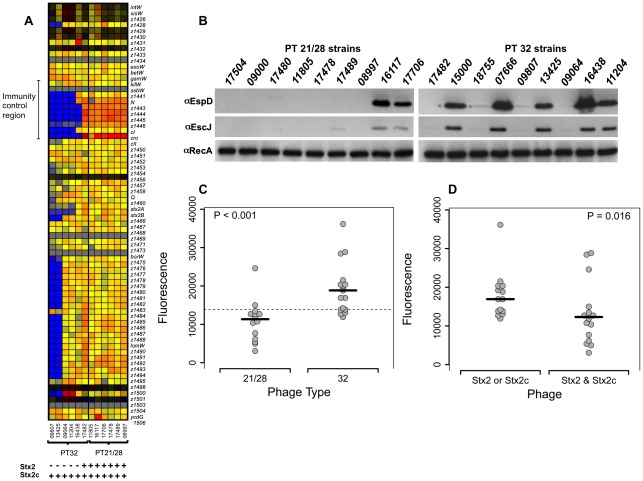
Comparison of EHEC O157 PT 21/28 and PT32 strains.(A) Comparative genome hybridisation of six PT21/28 and six PT32 strains. From left to right the PT21/28 strains are: 09807, 13425, 09064, 11204, 16438 & 17482; the PT32 strains are: 11805, 16117, 177706, 17478, 17489 & 08997 (table S1). The heat map shown indicates relative hybridisation levels of the defined strains to the Stx2 phage genome and flanking gene sequences from the O157:H7 Sakai strain which does not contain a Stx2c prophage. Red through to orange indicates a positive hybridization signal, with yellow a weakening signal through to blue colouration indicative of poor hybridization. All the PT21/28 strains show good relative hybridization to the sequences especially the gam-cII immunity region that is indicated. This is not the case for the PT32 strains with only 1 showing positive hybridisation over this same region, indicating that the remaining 5 strains are unlikely to contain the Stx2 phage. This was confirmed for the strains using a PCR to detect Stx2 and Stx2c phage control regions (Materials and Methods), the results of which are shown under the heat map lanes. The Stx phage distribution was then determined by PCR for 60 strains (table S1), please see Results section. (B) Western blot analysis of a subset of PT21/28 and PT32 strains as defined (table S1). EspD was detected from bacterial supernatants and EscJ and RecA from whole cell samples prepared as described in Materials and Methods. (C) Relative fluorescence levels from a LEE1-GFP reporter construct transformed into 14 PT21/28 and 16 PT32 strains with levels measured at OD600 = 1. The strains with mean values are defined in table S1. The median level of fluorescence from the PT32 strains is significantly higher than for the PT21/28 (p<0.001), the variability in expression levels correlates with the Western blotting data in part B. Also included is the overall median level (horizontal dashed line) (D) LEE1-GFP expression levels compared between strains containing either one or both Stx2 or Stx2c prophages. Strains containing both Stx2 phages have a significantly reduced (P = 0.016) median level of LEE1 expression compared with strains containing only one type of Stx2 prophage as determined at OD600 = 1 cultured in MEM-HEPES medium.